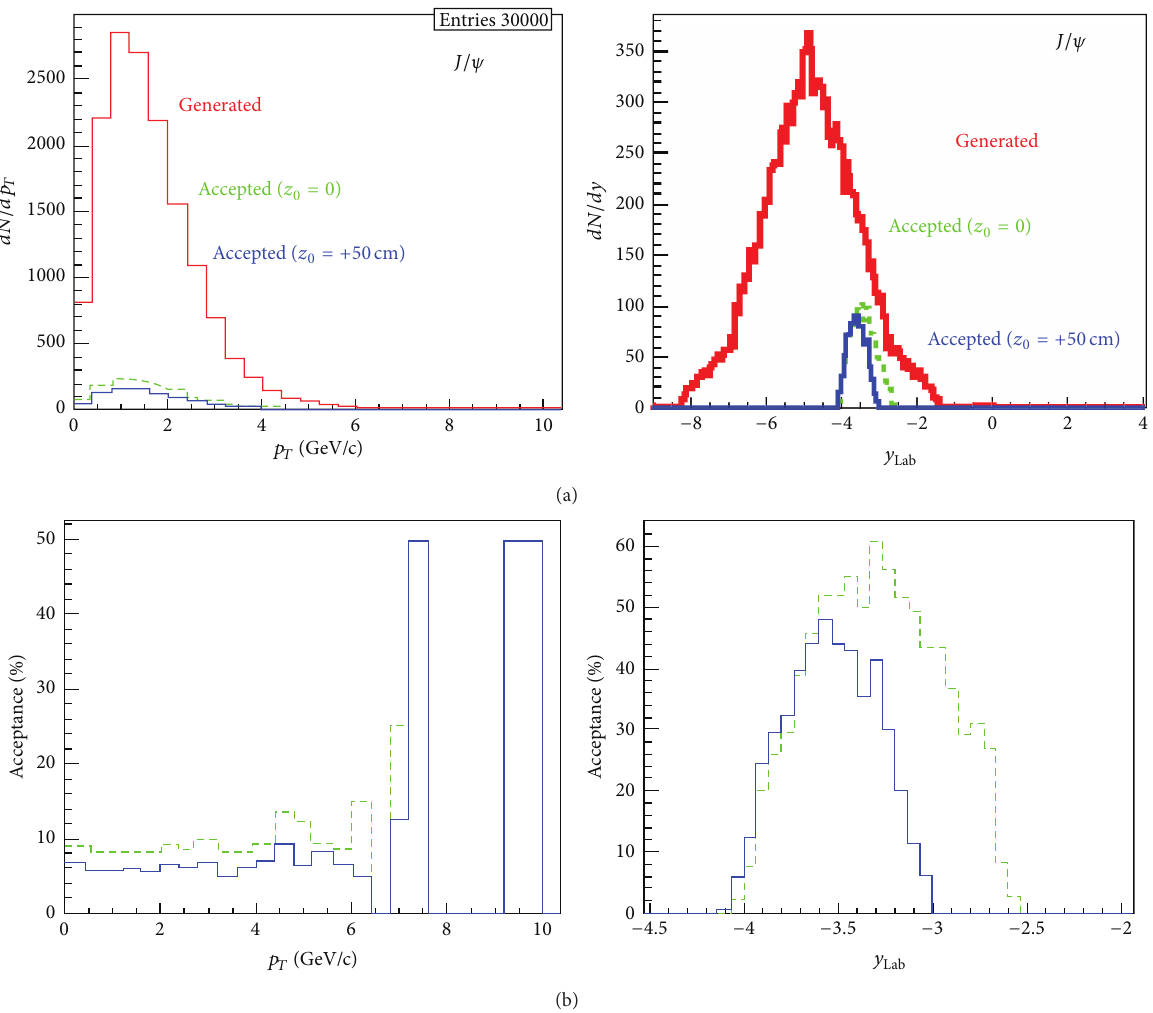
Figure 9: Transverse momentum and rapidity distributions for 𝐽/𝜓 events, produced at 𝑧 = +50cm (solid line) and at 𝑧 = 0 (dashed line) in fixed target p-A collisions at √𝑠 NN = 114.6 GeV per nucleon pair (a) and corresponding acceptances